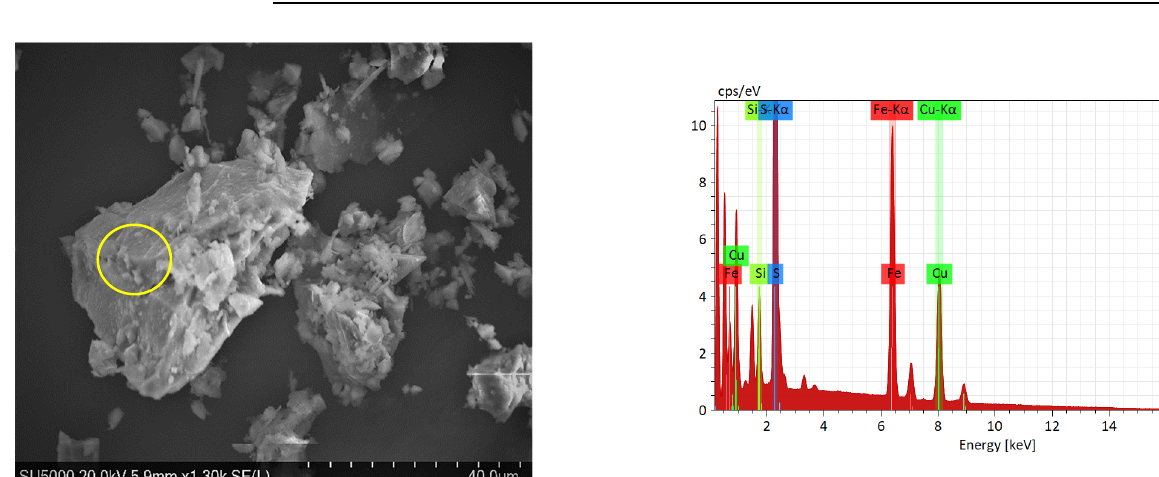
Figure 3. SEM and EDS micrograph of the chalcopyrite concentrate. Yellow circle shows EDS punctual analysis.